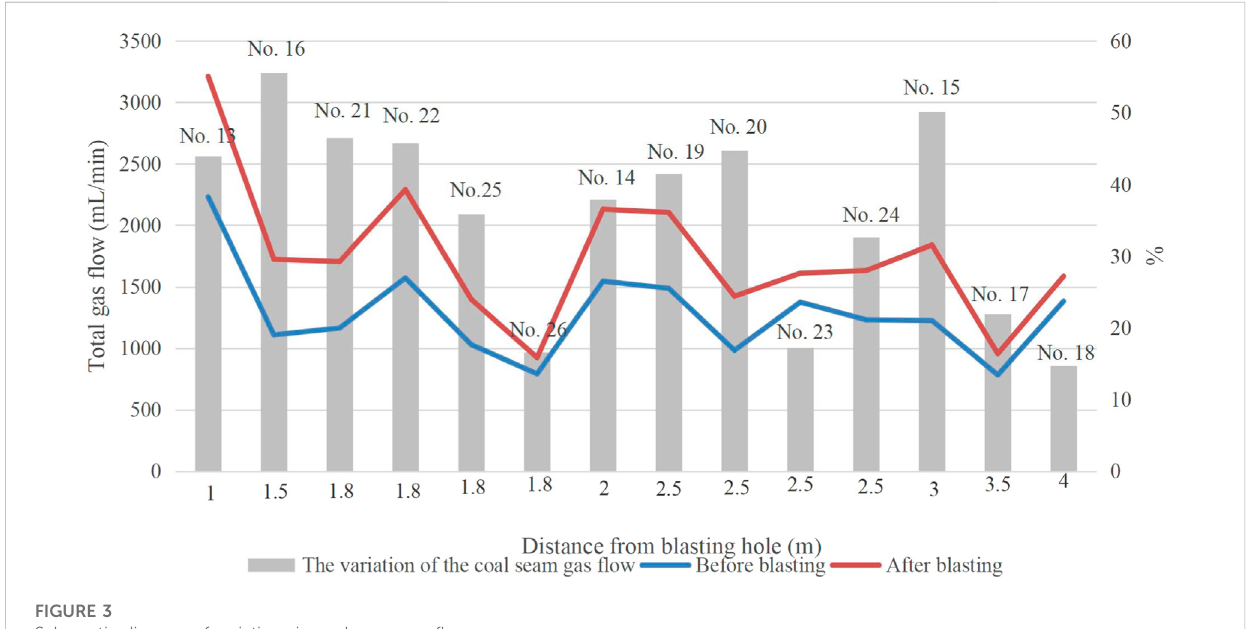
FIGURE 3 Schematic diagram of variations in coal seam gas fl